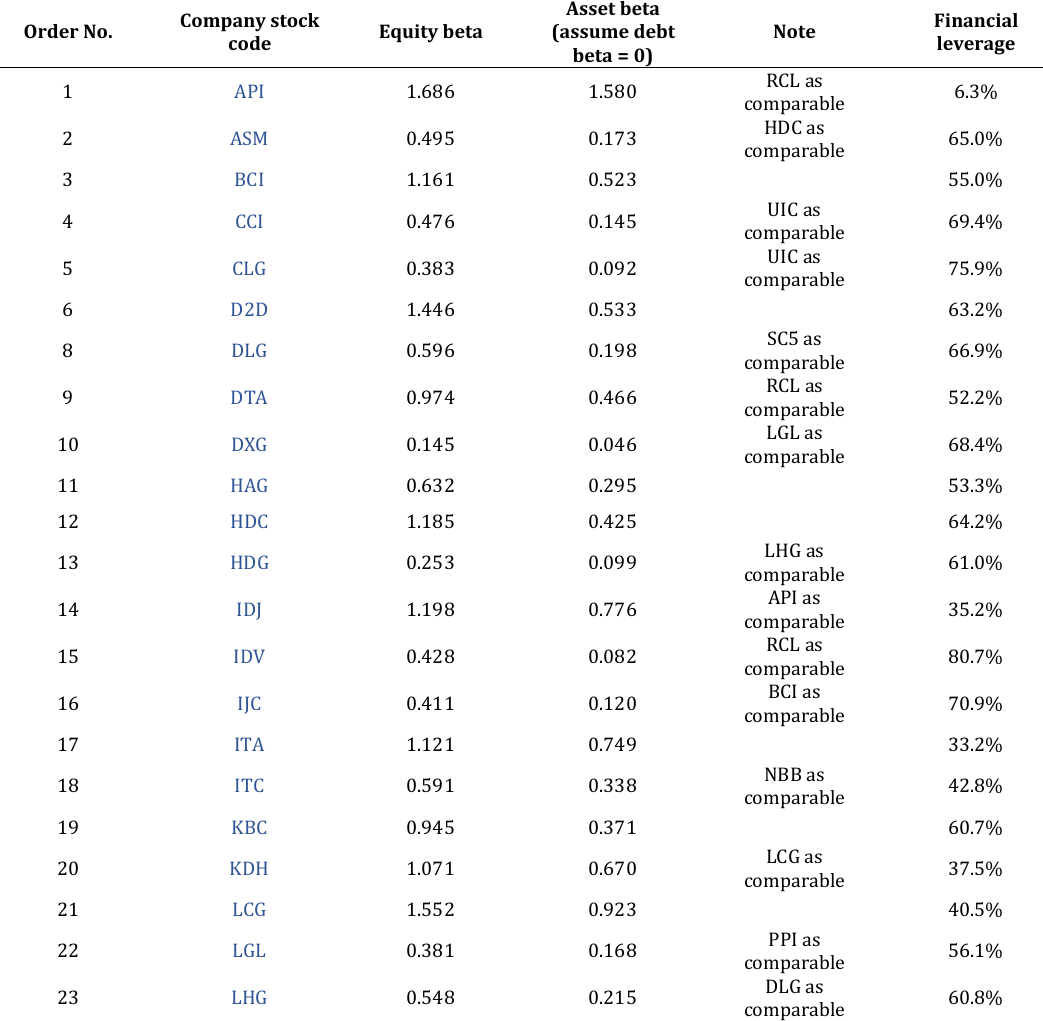
Table 1: Market risk of listed companies on VN real estate market (t = 25%) Order